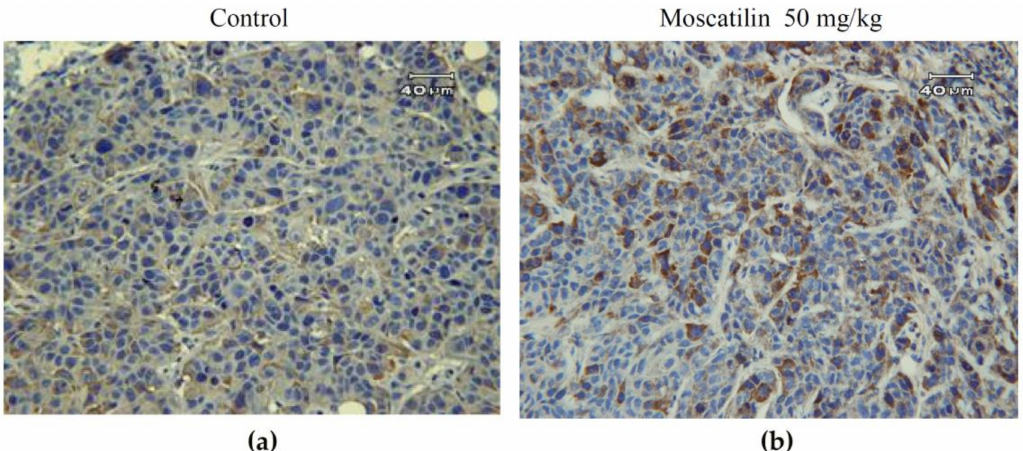
Figure 4. Representative immunohistochemistry slides showing phospho-Plk 1 protein expression in esophageal cancer CE81T/VGH xenograft tumor sections after treatment with control (dimethyl sulfoxide, DMSO) ( a ) or moscatilin ( b ) for 60 days.